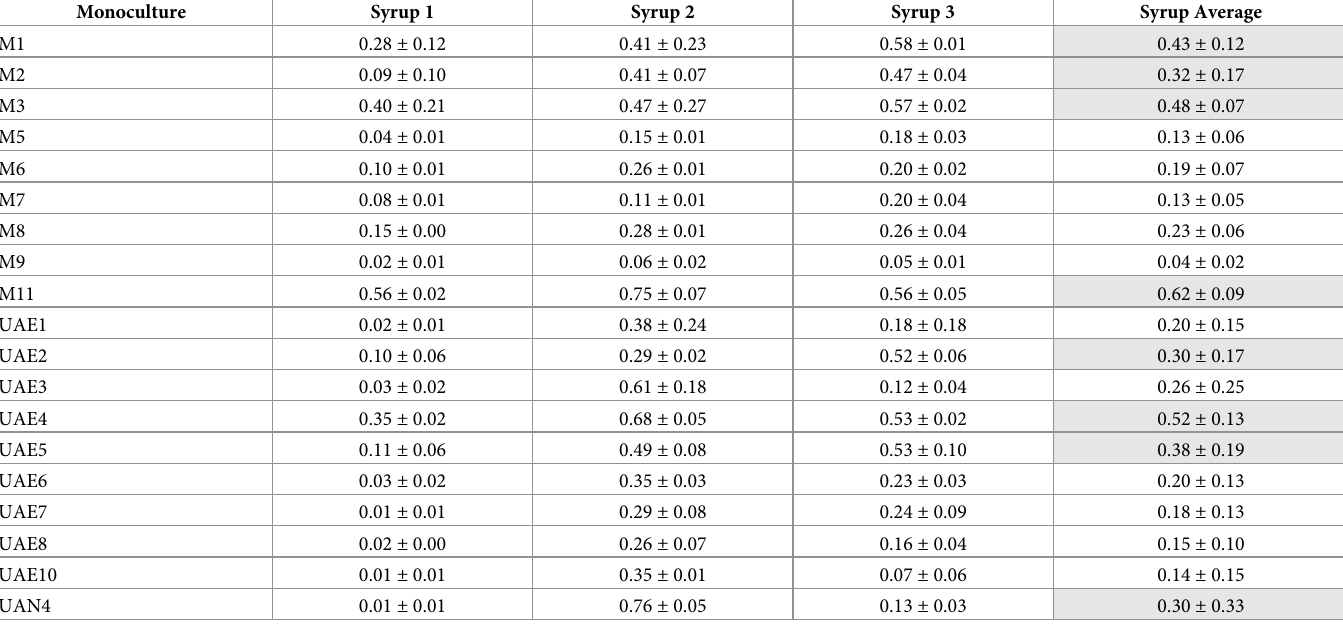
Table 3. Growth yields of monocultures on syrup from three production facilities a